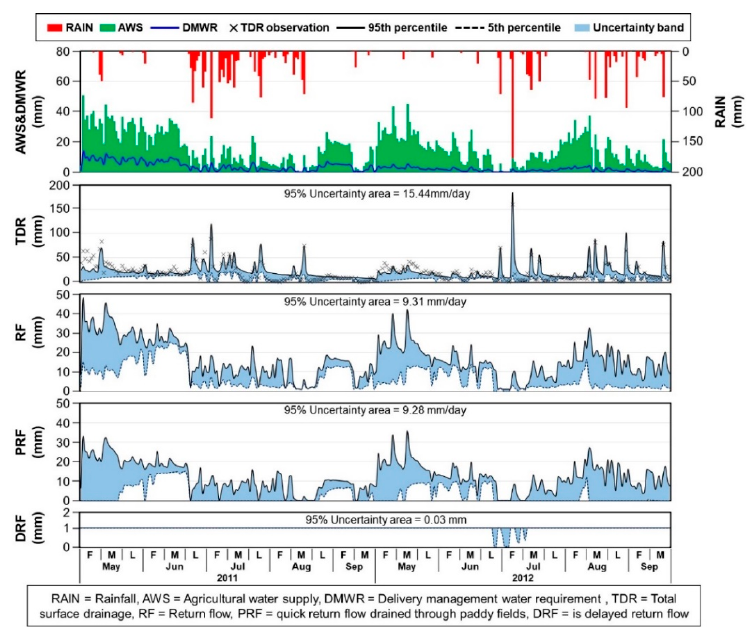
Figure 4. Temporal variations of inputs ( RAIN and AWS ), outputs ( DMWR , TDR , RF , PRF , and DRF ), and uncertainty (the 95% confidence interval) of output modeling using the Wide-CON approach. Simulated TDR is compared with the observations. Water 2020 , 12 , x